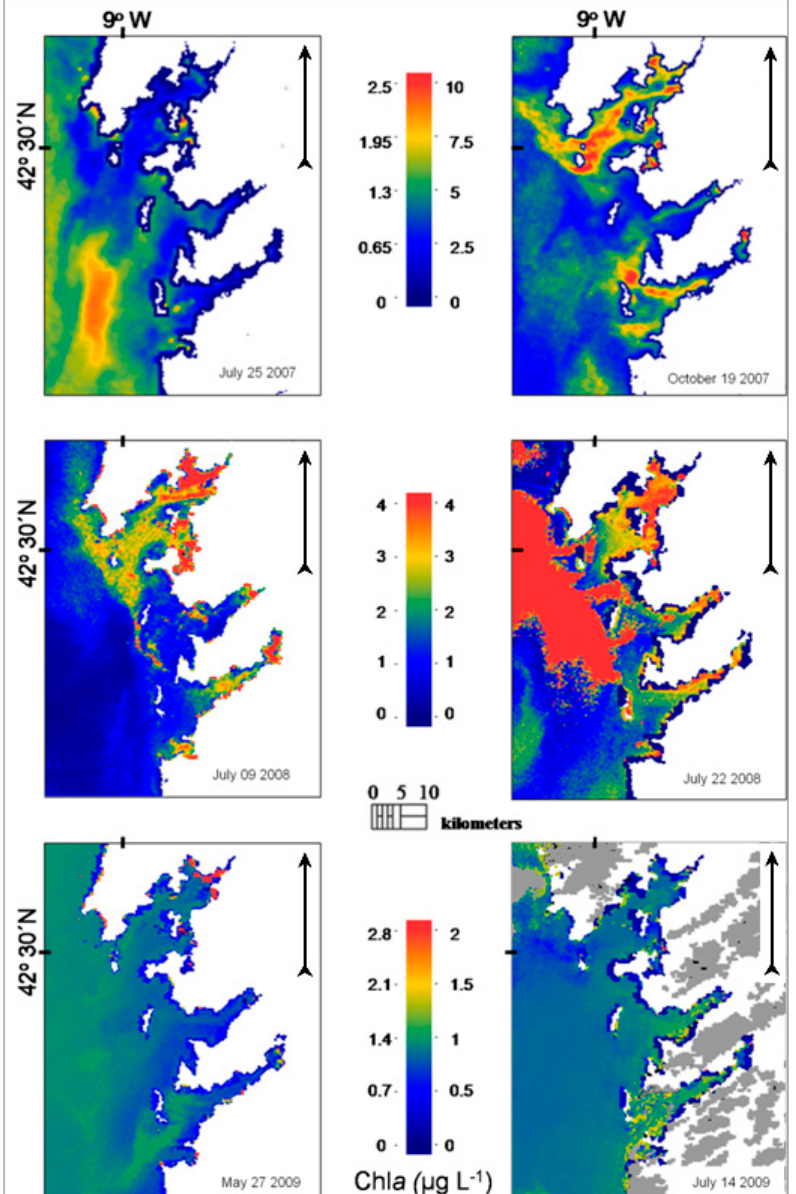
Figure 6. Chl a maps retrieved from MERIS full-resolution (FR) data using the neural network for rias Baixas (NNRB)on the survey dates. White colour indicates masking of land while grey masking of clouds. Pixels belonging to Cluster#2 and Cluster#3 were assigned a value of 0 (dark blue).